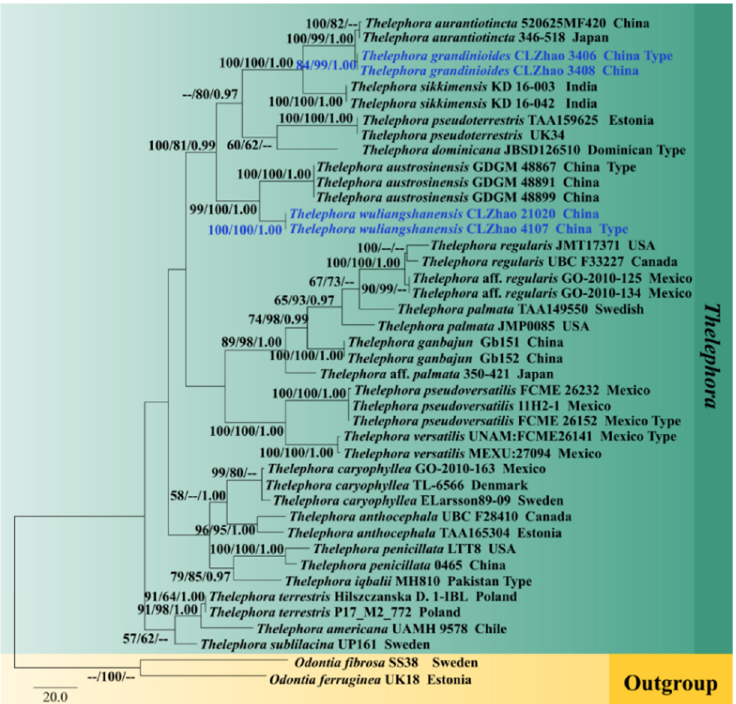
Figure 3. Maximum parsimony consensus tree based on the ITS sequences. Bootstrap support values for maximum likelihood (ML) equal to or higher than 60%, Bayesian Probability (PP) equal to or higher than 0.90, and maximum parsimony (MP) bootstrap proportions equal to or higher than 50% are mentioned above the branches (MP/ML/PP). Strains of the newly described species are depicted in blue.